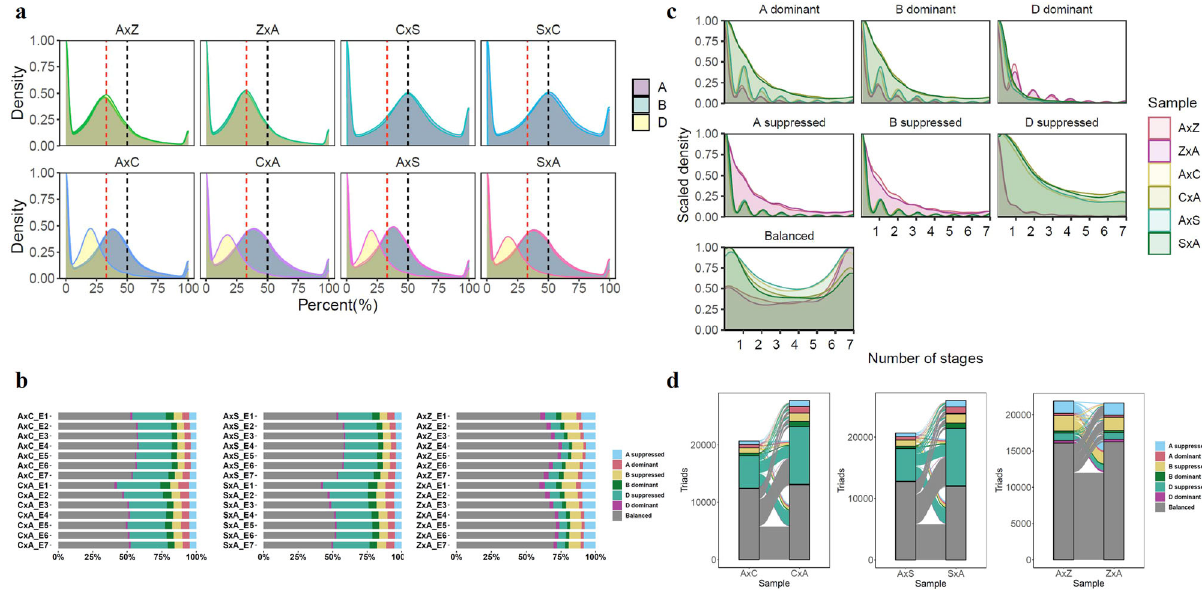
Fig. 5 Homoeologous gene expression pattern after hybridization between polyploidy wheat species. a Percent density of homoeologous triads on A, B and D genomes. b Percentage of homoeologue triads categorized into genome expression bias categories in reciprocal pairs at embryo stages. c Variation of triad expression patterns across seven embryo stages. Homoeologue triads were classi fi ed into the seven de fi ned categories including balanced, A dominant, B dominant, D dominant, A suppressed, B suppressed and D suppressed, based on relative normalized expression within each triad as described by Ramirez-Gonzalez et al. (2018). d Alluvial diagrams depicting the shifts of homoeolog expression bias categories between reciprocal crosses. Links between samples represent the triads that fl ow to the same or a different category between reciprocal cross. Triads belonging to each of the seven categories were colored to show shifts of triads between different